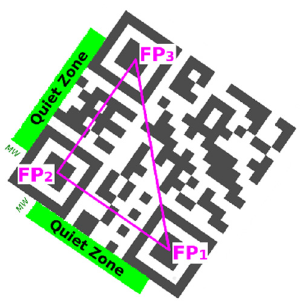
Figure 8. Quiet zones around QR Code.